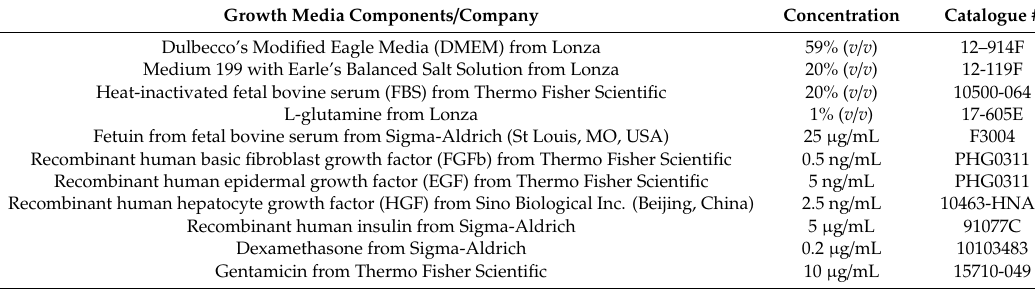
Table 1. Complete growth media for skeletal muscle cell